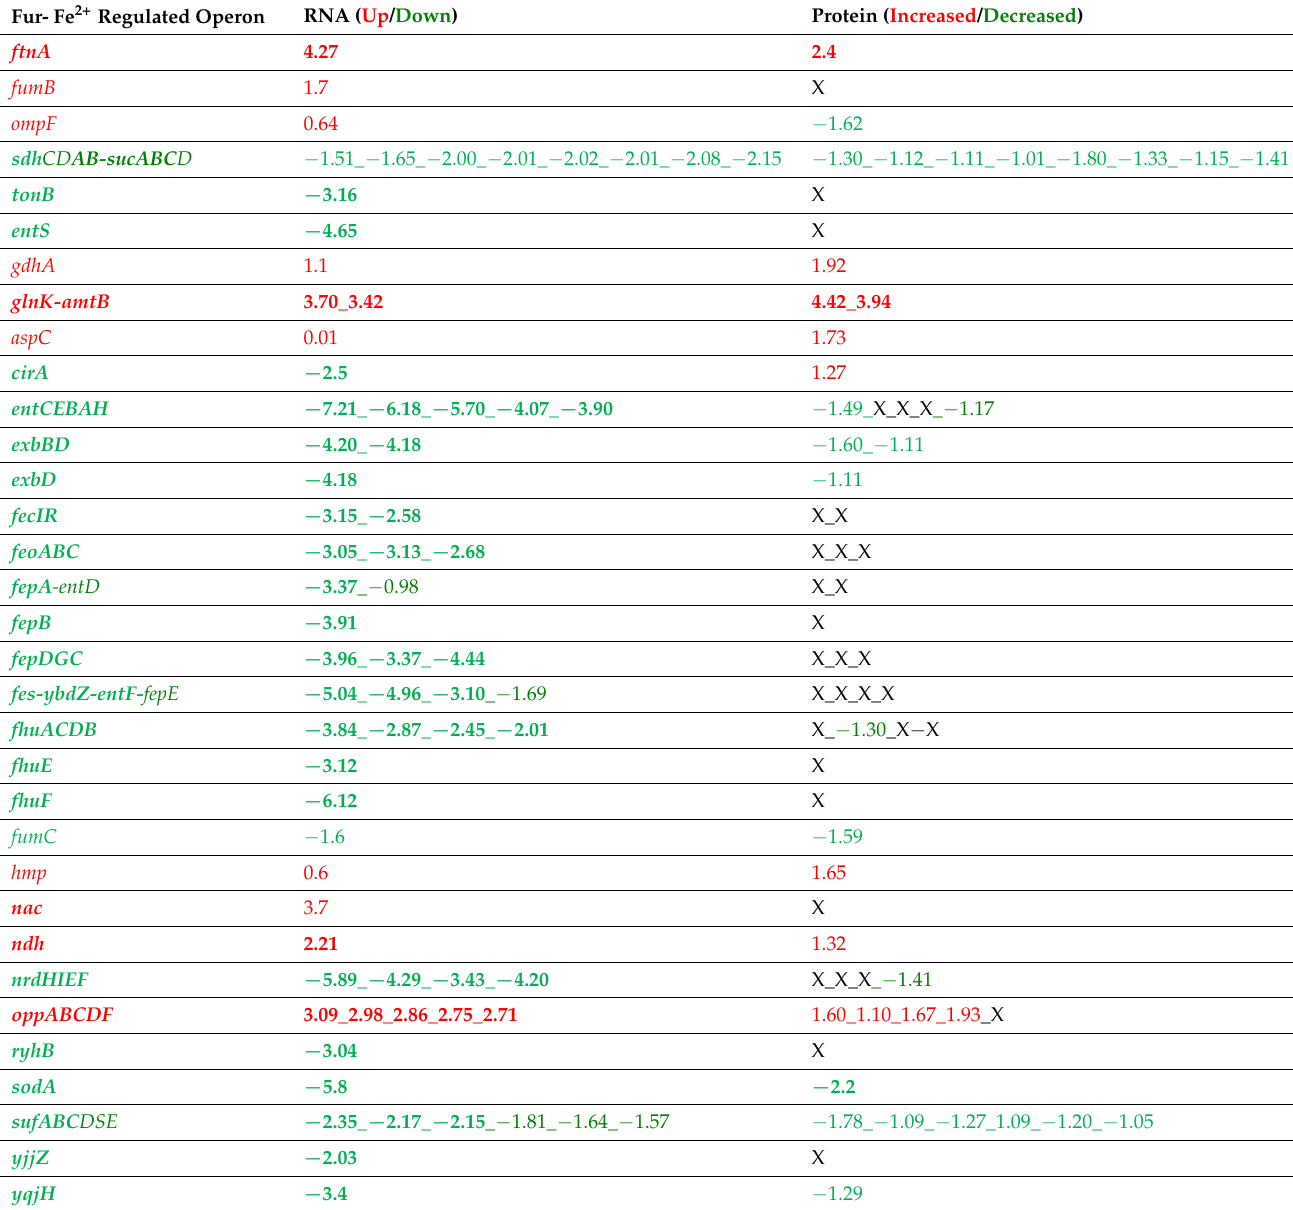
Table 5. Differential expression of genes that belong to the E. coli Fur